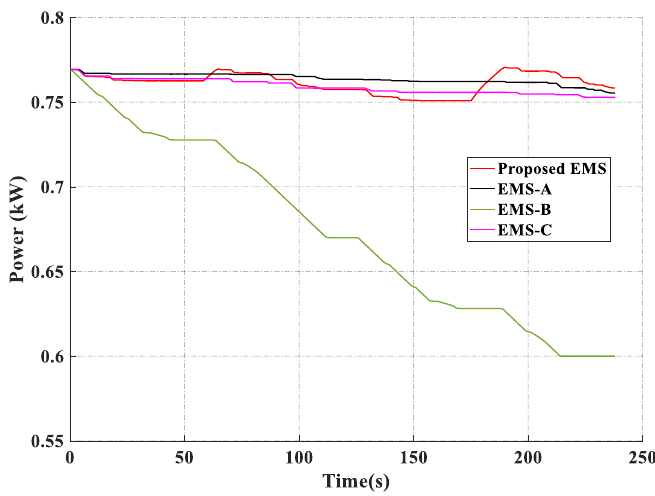
Figure 21. State of charge of the battery.